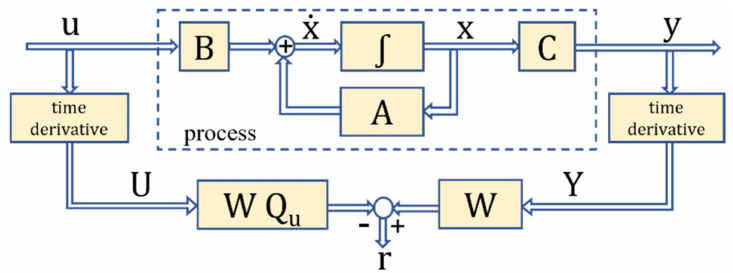
Figure 1. Simple parity equation scheme in state-space